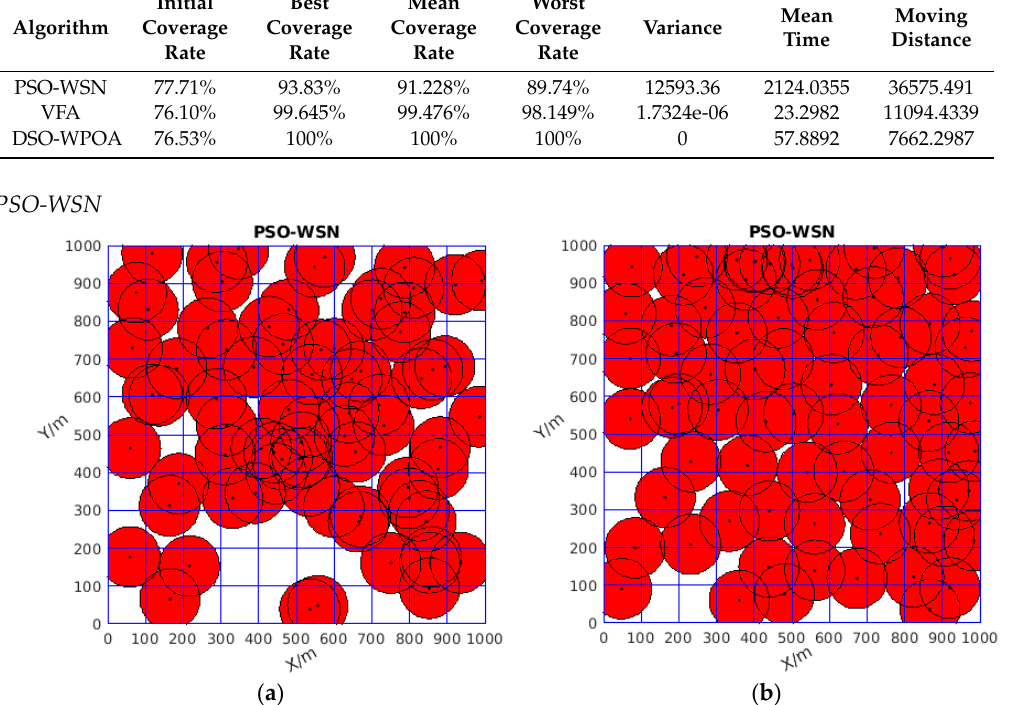
Figure 6. ( a ) The initial diagram of wireless sensor network coverage (distributed randomly); ( b ) the coverage optimized by the PSO.